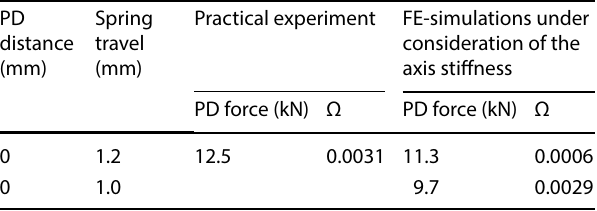
Table 4 Comparison of the wrinkle evaluation factors of FE simula- tion and practical experiment PD